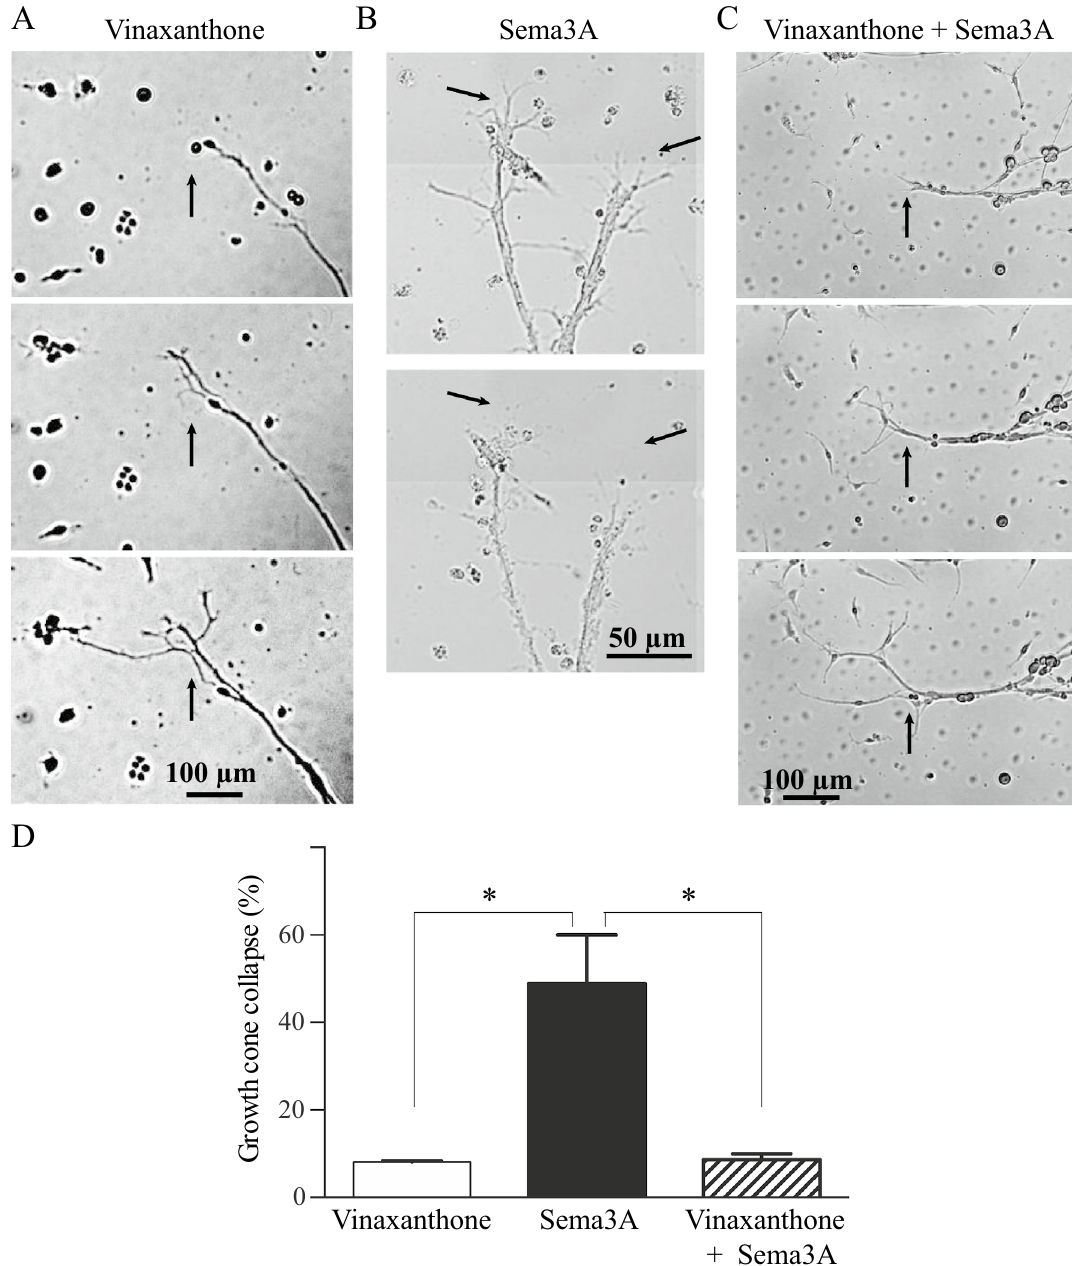
Figure 1. Vinaxanthone inhibits Sema3A-induced growth cone collapse in isolated embryonic DRG neurons. Isolated neurons from E15 wildtype mice were incubated with NGF to induce neurite sprouts. After 24 h abundant neurites with well-developed axon growth cones were observed. Addition of Vinaxanthone does not induce neurite regression or collapse of the axon growth cones ( A ), while Sema3A rapidly induces collapse of the axonal growth cones ( B ). Pre-incubation of the neurons with Vinaxanthone for 1 h before adding Sema3A blocked the axonal regression effect due to Sema3A and neuronal growth continued ( C ). The treatment’s effects on neuronal growth and regression were recorded via time lapse images (see Supplementary Videos S1, S2 and S3 in Supplementary Information) and analyzed as described in “Materials and methods”. The 50% increase in axon growth cone collapse induced by Sema3A, was reduced to basal levels in the presence of 0.1 μg/mL Vinaxanthone ( D ). Data represent the mean ± SEM of four independent experiments, with approximately 100 neurons were evaluated per treatment, a P value < 0.05 was considered statistically significant between the treatments, arrows indicate the starting point for video recording of neurite elongation/regression and selected time frames show the treatment